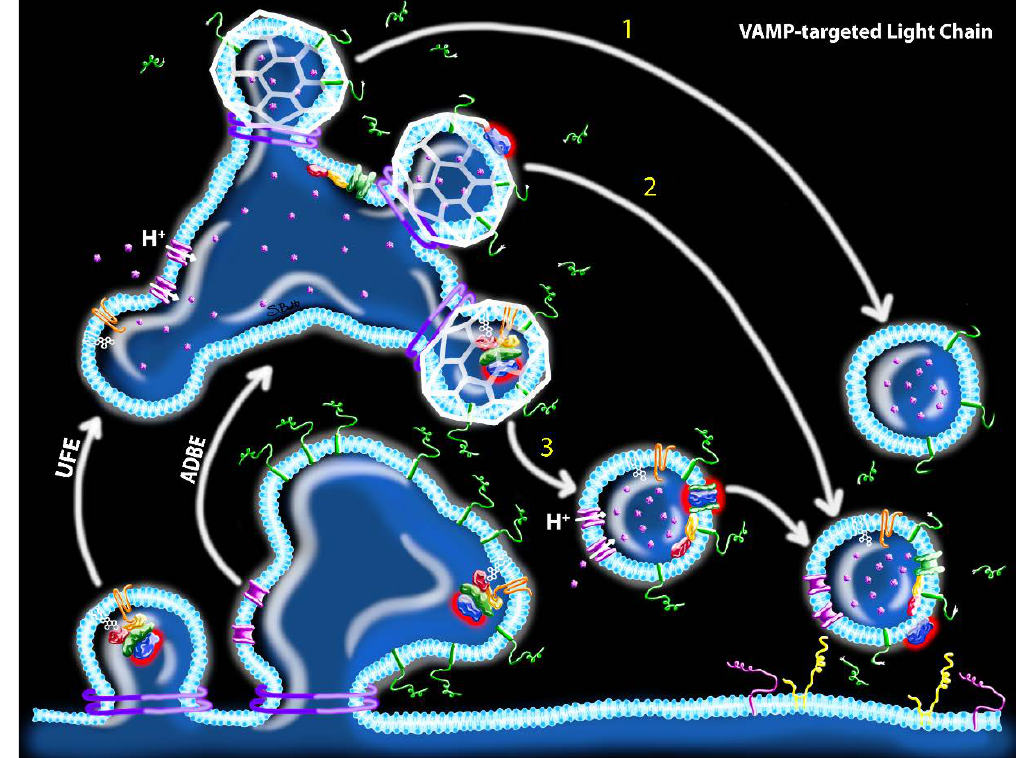
Figure 5. Hypothesized mechanisms of toxin uptake and potential proteolytic sites of action of VAMP-targeted LCs following UFE or ABDE. After fission from the presynaptic membrane, ABDE produces a bulk endosome, whereas UFE produces an endosome vesicle that subsequently fuses with a bulk endosome. vATPase proton pumps (pink) are activated during the bulk endosome stage, leading to slow acidification of bulk endosomes. Nascent SVs are produced from bulk endosomes via clathrin-coated (white) biogenesis with three potential outcomes: (1) vLC translocation (blue with red halo) and VAMP (green) cleavage occurs at the bulk endosome stage, producing SVs with cleaved VAMP that do not carry a vLC; (2) Similar to step 1, except a translocated vLC is captured on the SV during biogenesis; and (3) Acidification of the bulk endosome is not sufficient to drive translocation and intact holotoxin is captured within the SV during biogenesis. vLC translocation occurs after clathrin uncaging, producing SVs with active vLC that subsequently cleaves VAMP. In all three scenarios, the net result is a fusion-incompetent SV that futilely occupies release sites. Structures correspond to the key in Figure 2.